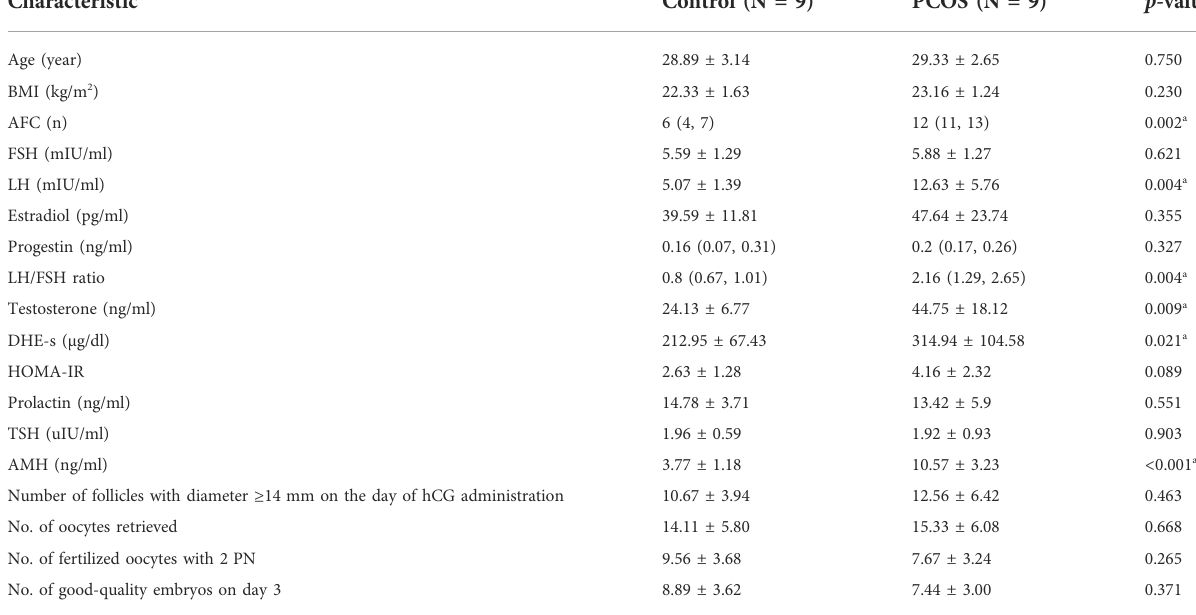
TABLE 1 Clinical baseline characteristics of patients with and without PCOS.